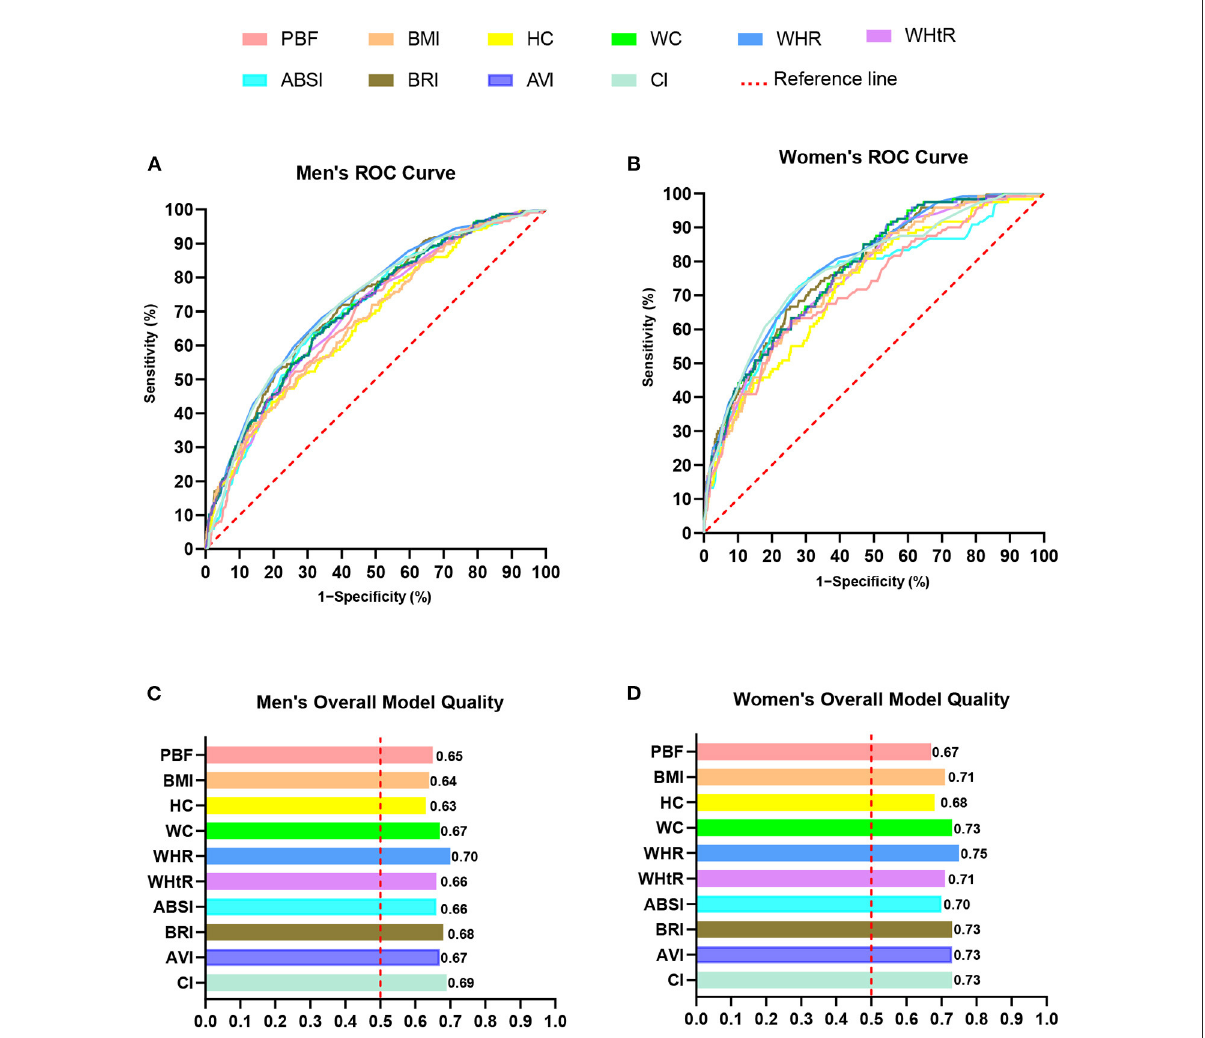
FIGURE1 ROC analysis of ten types of ORI for predicting hypertension. (A) Men’s ROC curve. (B) Women’s ROC curve. (C) Men’s overall model quality. (D) Women’s overall model quality. ORI, obesity-related indices; PBF, percent body fat; BMI, body mass index; HC, hip circumference; WC, waist circumference; WHR, waist–hip ratio; WHtR, waist–height ratio; ABSI, a body shape index; BRI, body roundness index; AVI, abdominal volume index; CI, conicity index.